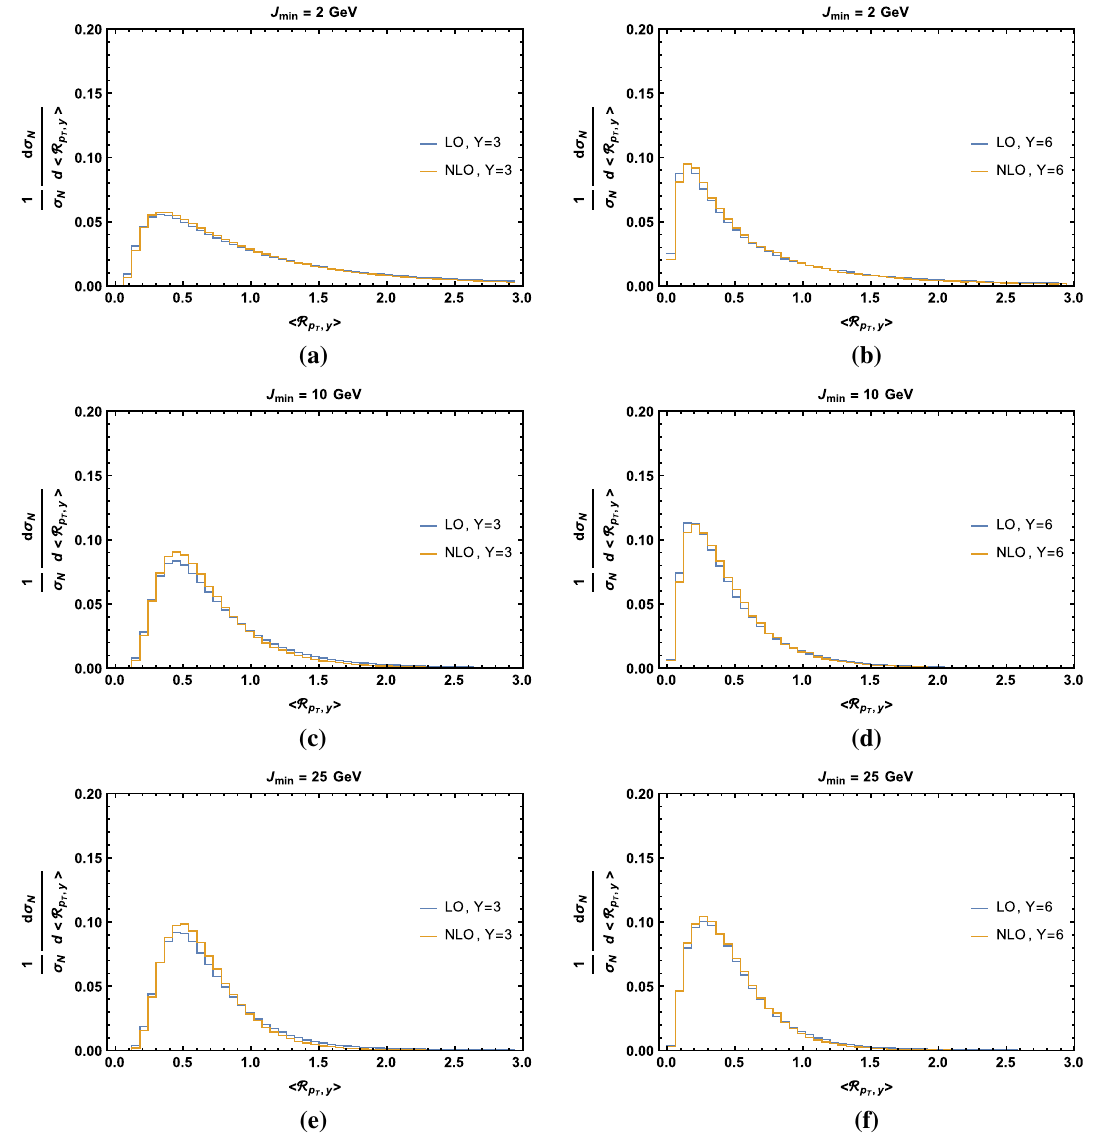
(cid:11) distributions for multiplicity N = 3, rapidity differences Y = 3 (left) and Y = 6 T , y